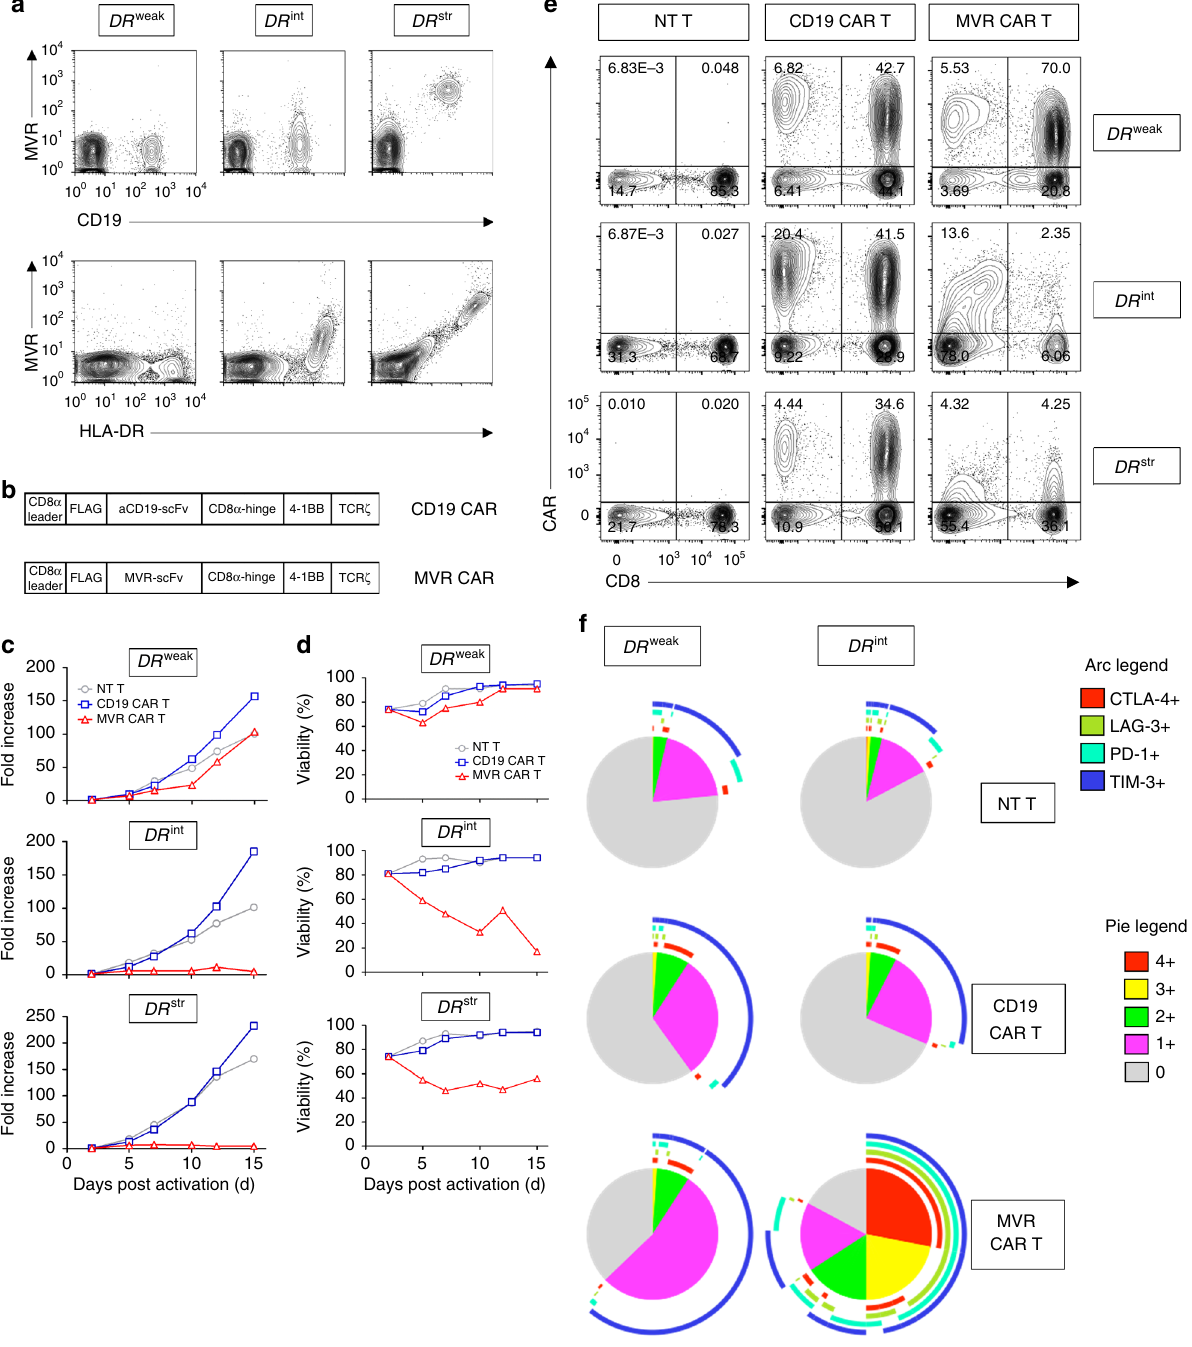
Fig. 1 MVR CAR T cells undergo reduced fratricide and exhaustion when their binding to HLA-DR is weak. Cells from donors with different HLA-DRB1 alleles exhibiting strong, intermediate, or weak binding with MVR ( DR str , DR int , or DR weak , respectively; a ) were used in the following experiments. a Binding pattern of the MVR antibody. DR str , DR int , and DR weak peripheral blood mononuclear cells (PBMCs) were analyzed for CD19 and HLA-DR expression. b Second-generation CAR constructs designed using anti-CD19 or MVR antibody. c , d Growth ( c ) and viability ( d ) after transduction of DR str , DR int , and DR weak PBMCs. Fold-increases in cell counts (relative to the number on day 0) and viabilities of non-transduced (NT) T, CD19 CAR T, and MVR CAR T cells were measured at the indicated time points. Both CD19 CAR T and MVR CAR T cells were transduced on day 2. e Expression of CAR on NT T, CD19 CAR T, and MVR CAR T cells generated from DR str , DR int , and DR weak PBMCs. Cells were analyzed for CD8 and CAR expression at 13 days post- transduction. f Expression of multiple exhaustion markers was assessed in NT T, CD19 CAR T, and MVR CAR T cells generated from DR int and DR weak PBMCs. The length of the arc of each color indicates the frequency of expression of the corresponding marker. The area of the pie of each color indicates the frequency of cells that express the given number of exhaustion markers. The expression of exhaustion markers in each CAR T cell type was analyzed by gating on CAR-positive cells (Supplementary Fig. 1). Pie charts were drawn based on the fl ow cytometry data measured in Supplementary Fig. 1 using a SPICE v5.0 (NIAID). a , c – f Representative of two independent